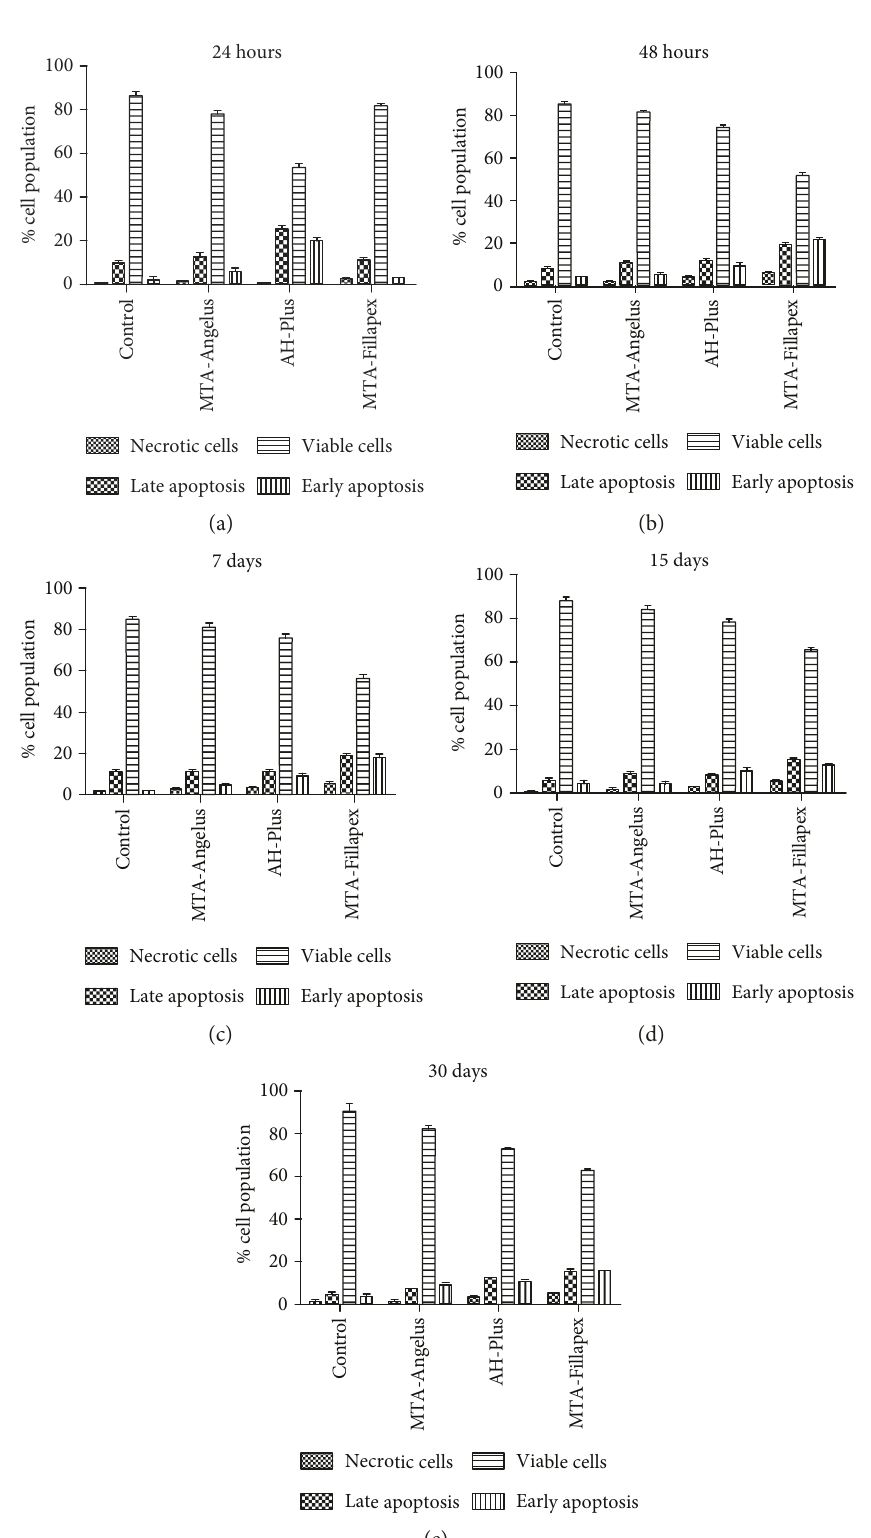
Figure 1: Cytotoxicity induced on HDPSCs assessed using fl ow cytometry by 1 :2 dilutions of preconditioned cell culture medium with endodontic materials at 24 hours. Graphs show cell population as viable cells, early apoptotic cells, late apoptotic cells, and necrotic cells at (a) 24hours, (b) 48 hours, (c) 7 days, (d) 15 days, and (e) 30 days. Each condition was tested by triplicate in three independent samples. The statistical test used was ANOVA with a post hoc Newman-Keuls test to analyze changes in viable, apoptotic, and necrotic cells in each condition. In Table 1, the values of statistical signi fi cance for each comparison are